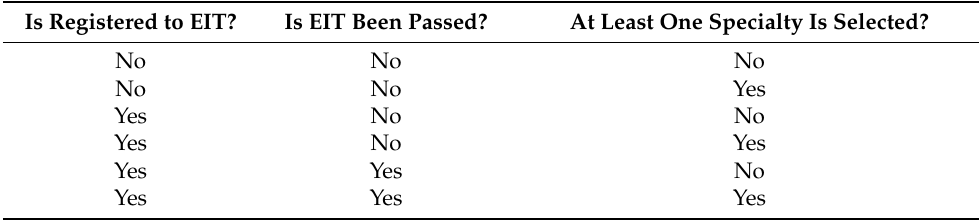
Table 1. Entrants’ target audience for the recommendation problem. Is Registered to